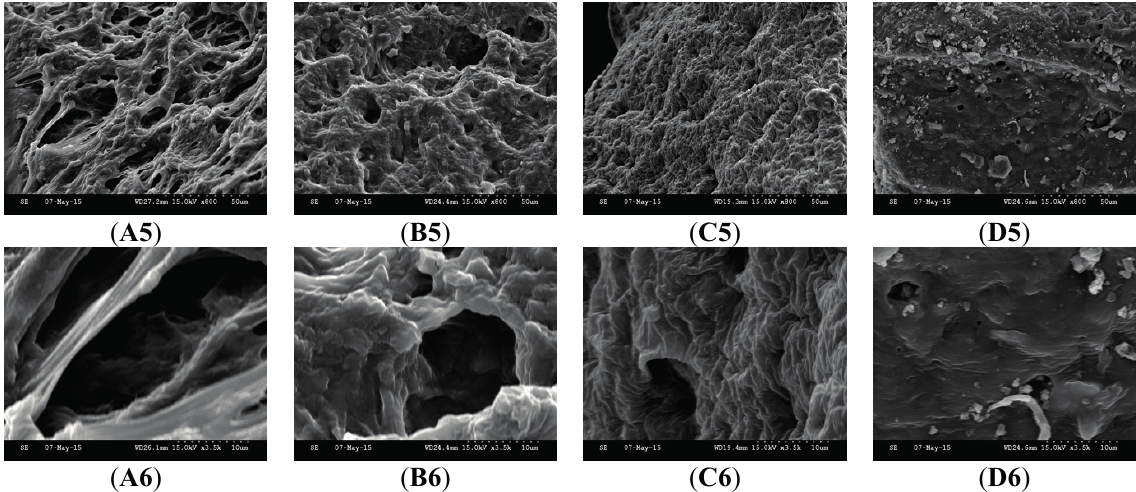
Figure 3. SEM images of freeze-dried PEO hydrogel network. ( A ) PEO-PETRA 1% w / w , ( B ) PEO-PETRA 2.5% w / w , ( C ) PEO-PETRA 5% w / w , ( D ) PEO-PETRA 10% w / w . Scale bars are 200, 50 and 5 μ m for micrographs featuring the outer surface of hydrogel network (1–3), 100, 50 and 10 μ m for micrographs featuring the cross section of hydrogel network